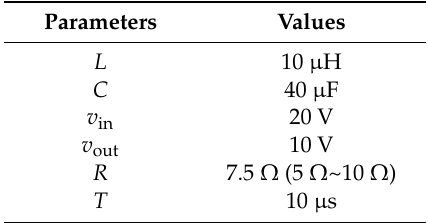
Table 2. Main specifications of the buck converter.